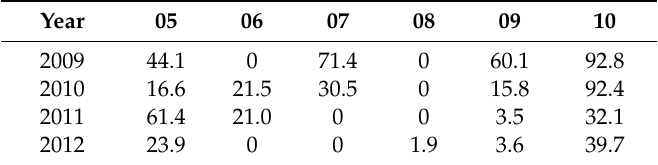
Table 1. Precipitation (mm) of the critical months recorded in the Dekelia weather station during the study